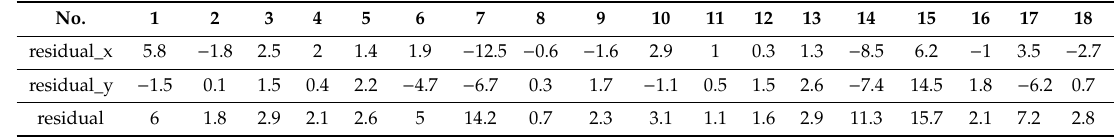
Table 1. The residual error (cm) of the 18 feature points. Residual_x and residual_y are residual errors Figure 8. The occupancy likelihood maps near the start/end point, generated by our proposed of the x-coordinate and y-coordinate, respectively, and residual is the root mean square of residual_x OWOLM ( a ) and the traditional OLM ( b ) approach. Brighter intensities indicate higher likelihood and values. Red numbers represent biases between two contours in the red ellipsoid.